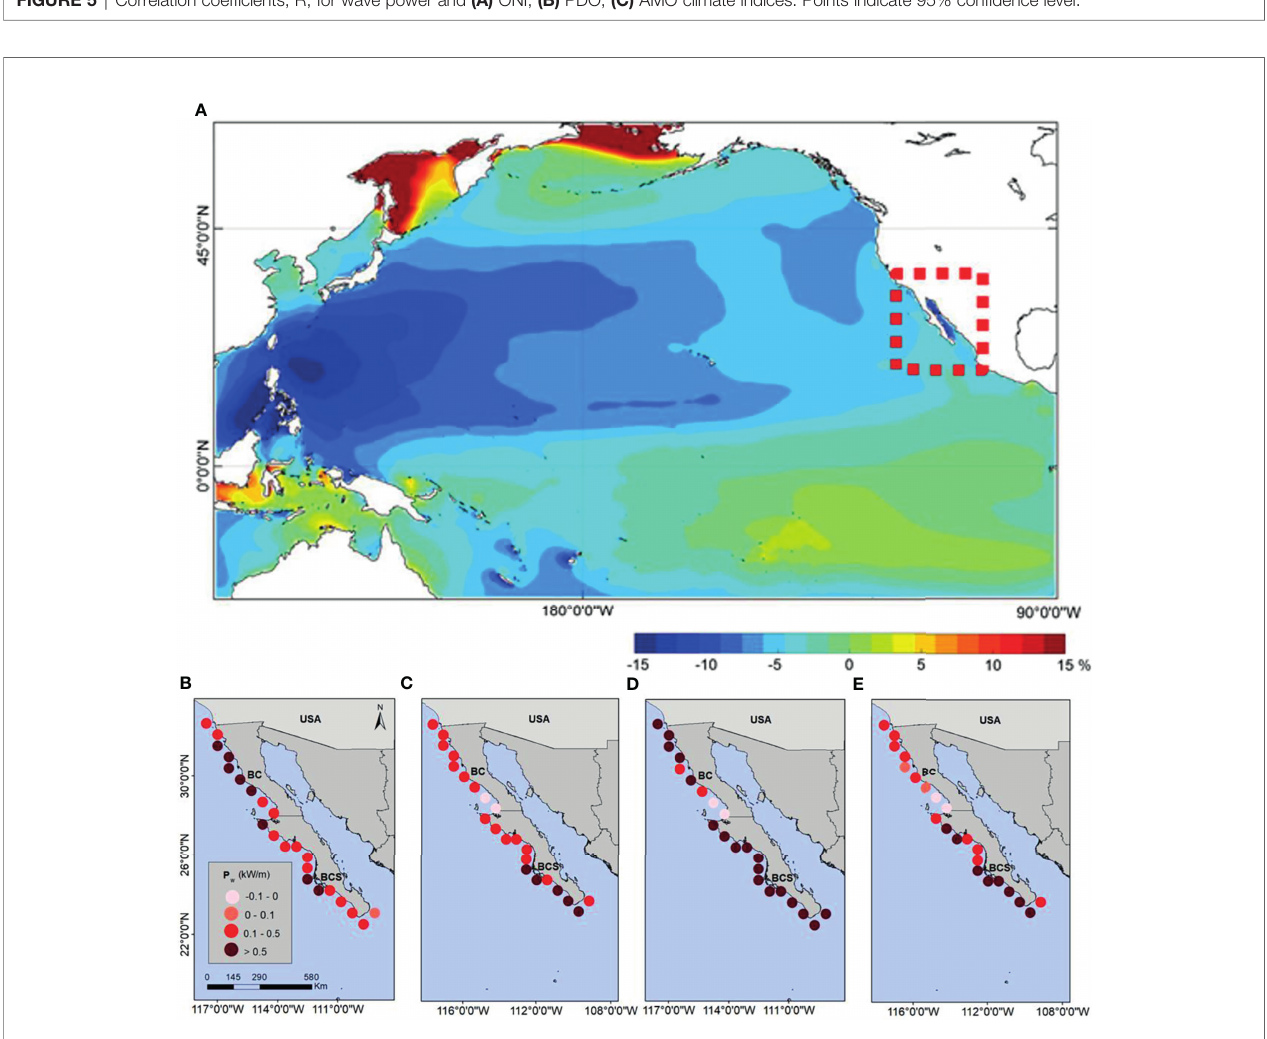
FIGURE 6 | Differences between RCP 8.5 scenario and the baseline conditions: (A) annual signi fi cant wave height change (percentage) in the North Paci fi c; seasonal differences in wave power in Baja California during (B) winter, (C) spring, (D) summer, and (E)